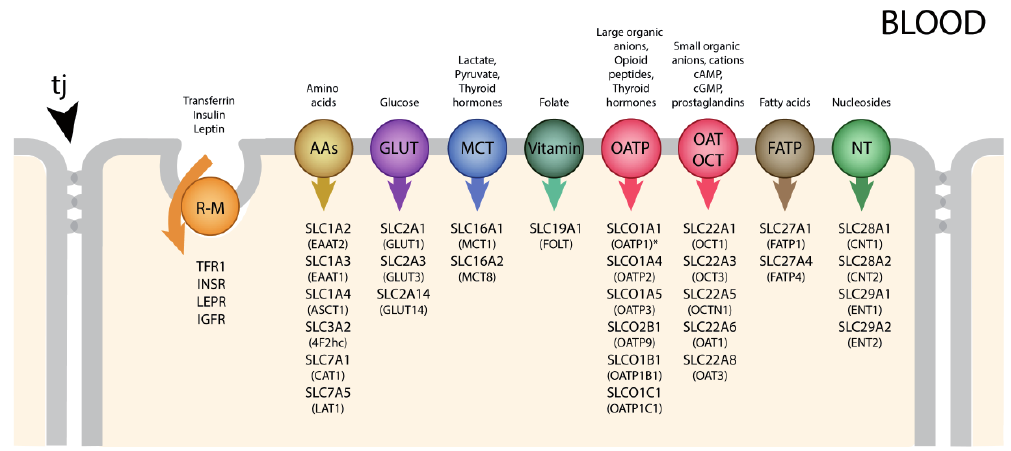
Figure 4. Summary of inward transporter mechanisms in cerebral endothelial cells. Individual transporters shown are ones identified in human material 29 . Tight junctions (tj) between adjacent cells prevent the paracellular passage of hydrophilic compounds. R-M = receptor- mediated, GLUT = glucose transporters, NTs = nucleoside transporters, AAs = amino acid transporters (includes LAT), OATP = organic anion transporting polypeptides, OAT = organic anion transporters, OCT = organic cation transporters, MCT = monocarboxylate transporters, FATP = fatty acid transport protein. Many of these transporters are solute linked carriers (SLCs). Both SLC designations and the original abbreviations are included here. SLC1A2/EAAT2, SLC1A3/EAAT1 high-affinity glutamate, SLC1A4/ASCT1 glutamate/neutral amino acids, SLC2A1/GLUT1, SLC2A3,14/GLUT3 glucose, SLC3A2/4F2hc amino acid transporter heavy chain, SLC6A12/BGT1 neurotransmitter, SLC7A1/CAT1 cationic amino acid, y+ system, SLC7A5/LAT1 amino acid light chain, L system, SLC10A1/NTCP sodium/bile acid cotransporter. SLC16A1/MCT1, SLC16A2/MCT8 monocarboxylates, SLC19A1/RFC folate, SLC22A1/OCT1 organic cations, SLC22A3/OCTN3 organic cations, SLC22A5/OCTN2 organic cation/carnitine, SLC27A1/FATP1 fatty acid, SLC29A1/ENT1 equilibrative nucleosides, SLCO2B1/OATP2B1 organic anions, SLCO1B1/OATP1B1 organic anions. Examples of receptor-mediated transporters are insulin receptor (INSR), transferrin receptor (TFR1), leptin receptor (LEPR), low-density lipoprotein receptor (LDLR), and insulin-like growth factor receptor